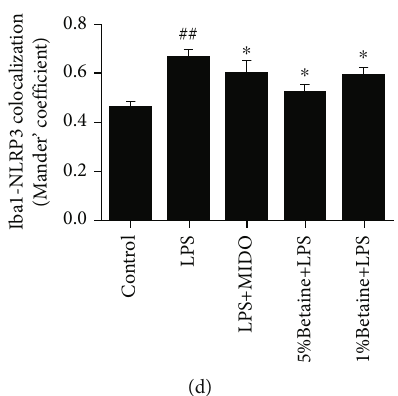
Figure 7: Betaine reduces the expression of NLRP3 in fl ammasome in mice GD brain region. Immunostaining with anti-NLRP3 (green) and anti-Iba1 (microglia activation marker, (red) antibodies, and nuclei stained with DAPI (blue). (a) Representative images of NLRP3 fl uorescence intensity after stimulation with LPS. (b) Analysis of NLRP3 fl uorescence intensity in brain regions. (c) Analysis of Iba1 fl uorescence intensity in brain regions. (d) Colocalization analysis of NLRP3 and Iba1. The results were expressed as mean ± SEM ; ## P < 0 : 01 and ### P < 0 : 001 compared to the normal control group; ∗ P < 0 : 05 and ∗∗∗ P < 0 : 001 compared to the model group, n = 6